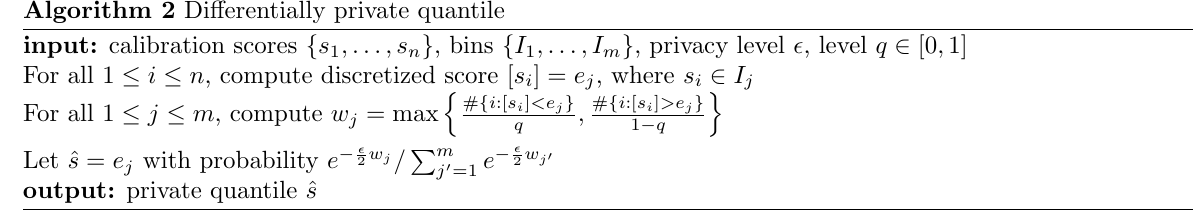
Algorithm 2 with appropriately chosen quantile level q as a subroutine of our main conformal procedure. Algorithm 2 Differentially private quantile